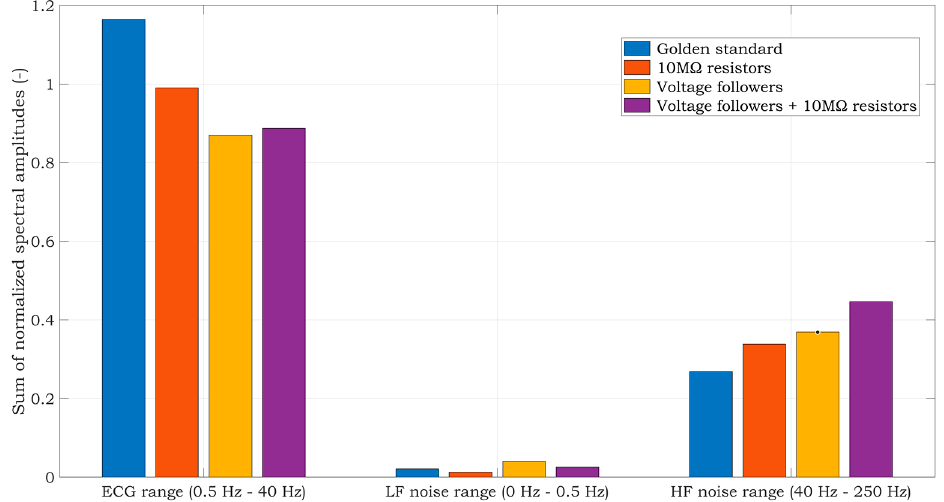
Figure 12. Frequency-domain analysis of raw ECG signals measured from a living subject.